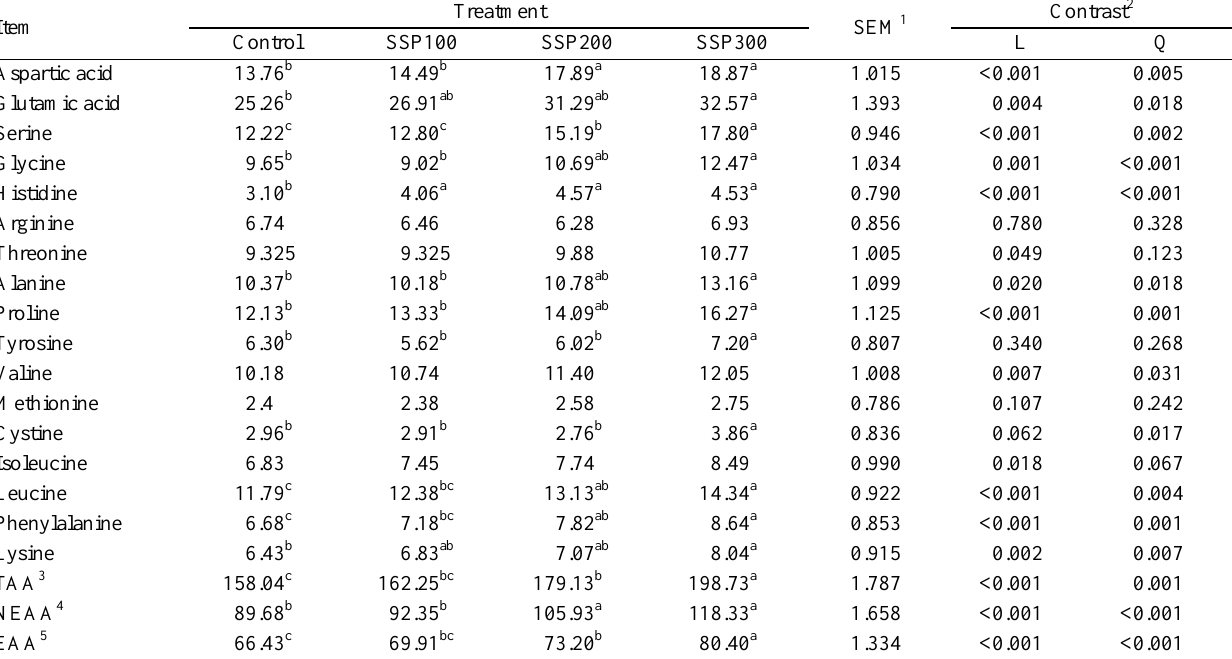
Table 7. Effects of soybean small peptide (SSP) infusion into rumen at the rates of 0 (Control), 100 (SSP100), 200 (SSP200) and 300 (SSP300) g/d on flux of amino acids at the terminal ilenum of Luxi Yelow cattle (n = 4)